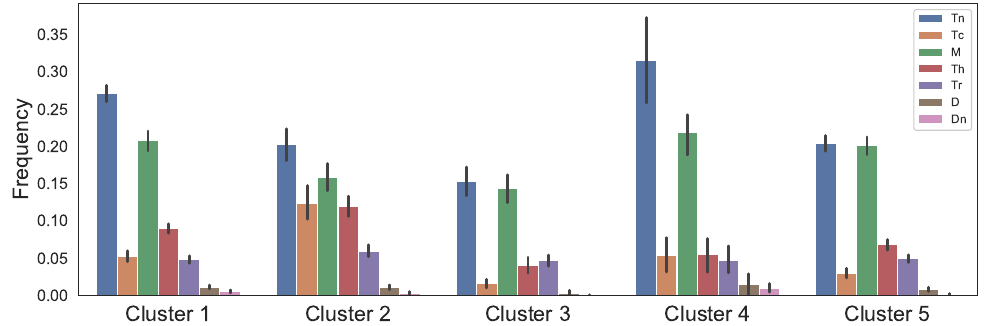
Figure 2. Model immune cells fractions. Clusters are obtain based on variations in 22 immune cell types of colonic